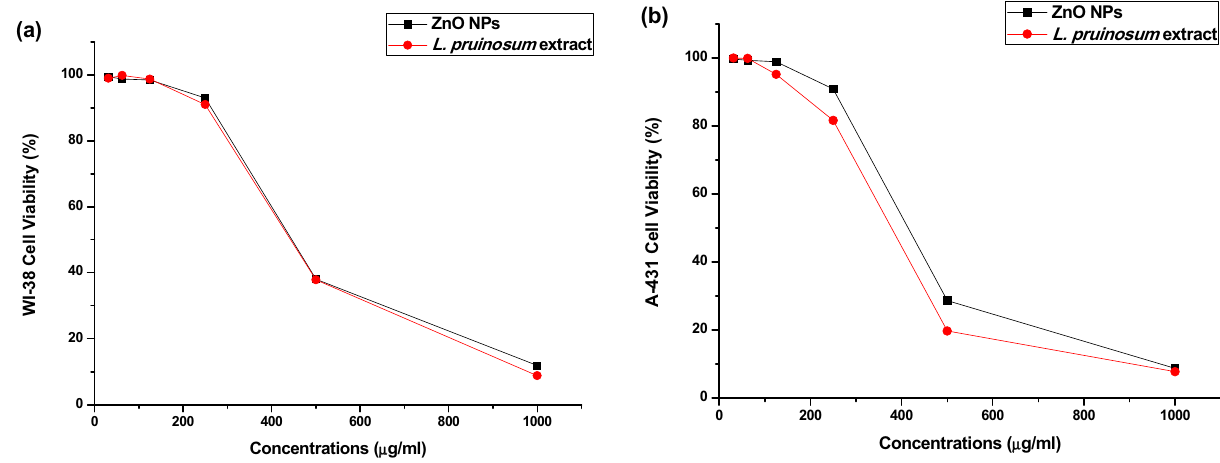
Figure 5. Cell viability % efficiency of the phytosynthesized ZnO NPs and L. pruinosum extract against ( a ) normal lung fibroblast cells (WI-38) and ( b ) cancerous cells